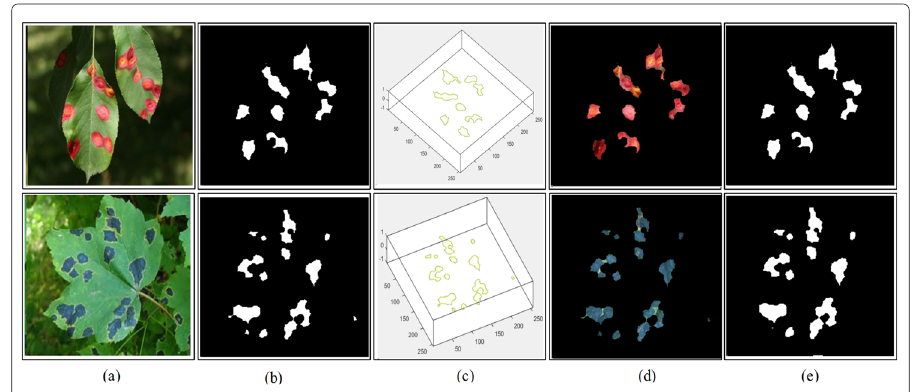
Fig. 10 Proposed segmentation results with their respective ground truth image. a Original image. b Segmented image. c Contour of infection part. d Infection part mapped on the original image. e Ground truth image